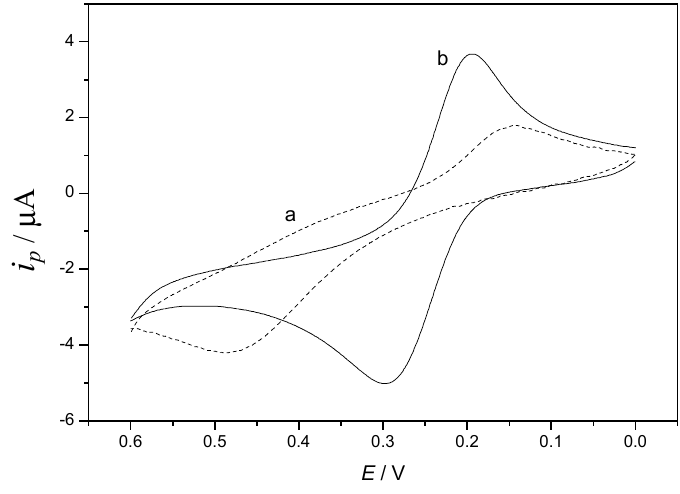
Figure 3. Cyclic voltammograms of 1.0 mM NE on bare gold electrode (a) and on ME/Au SAMs modified electrode (b) in B-R buffer (pH 5.5) at a scan rate of 50 mV s -1 .